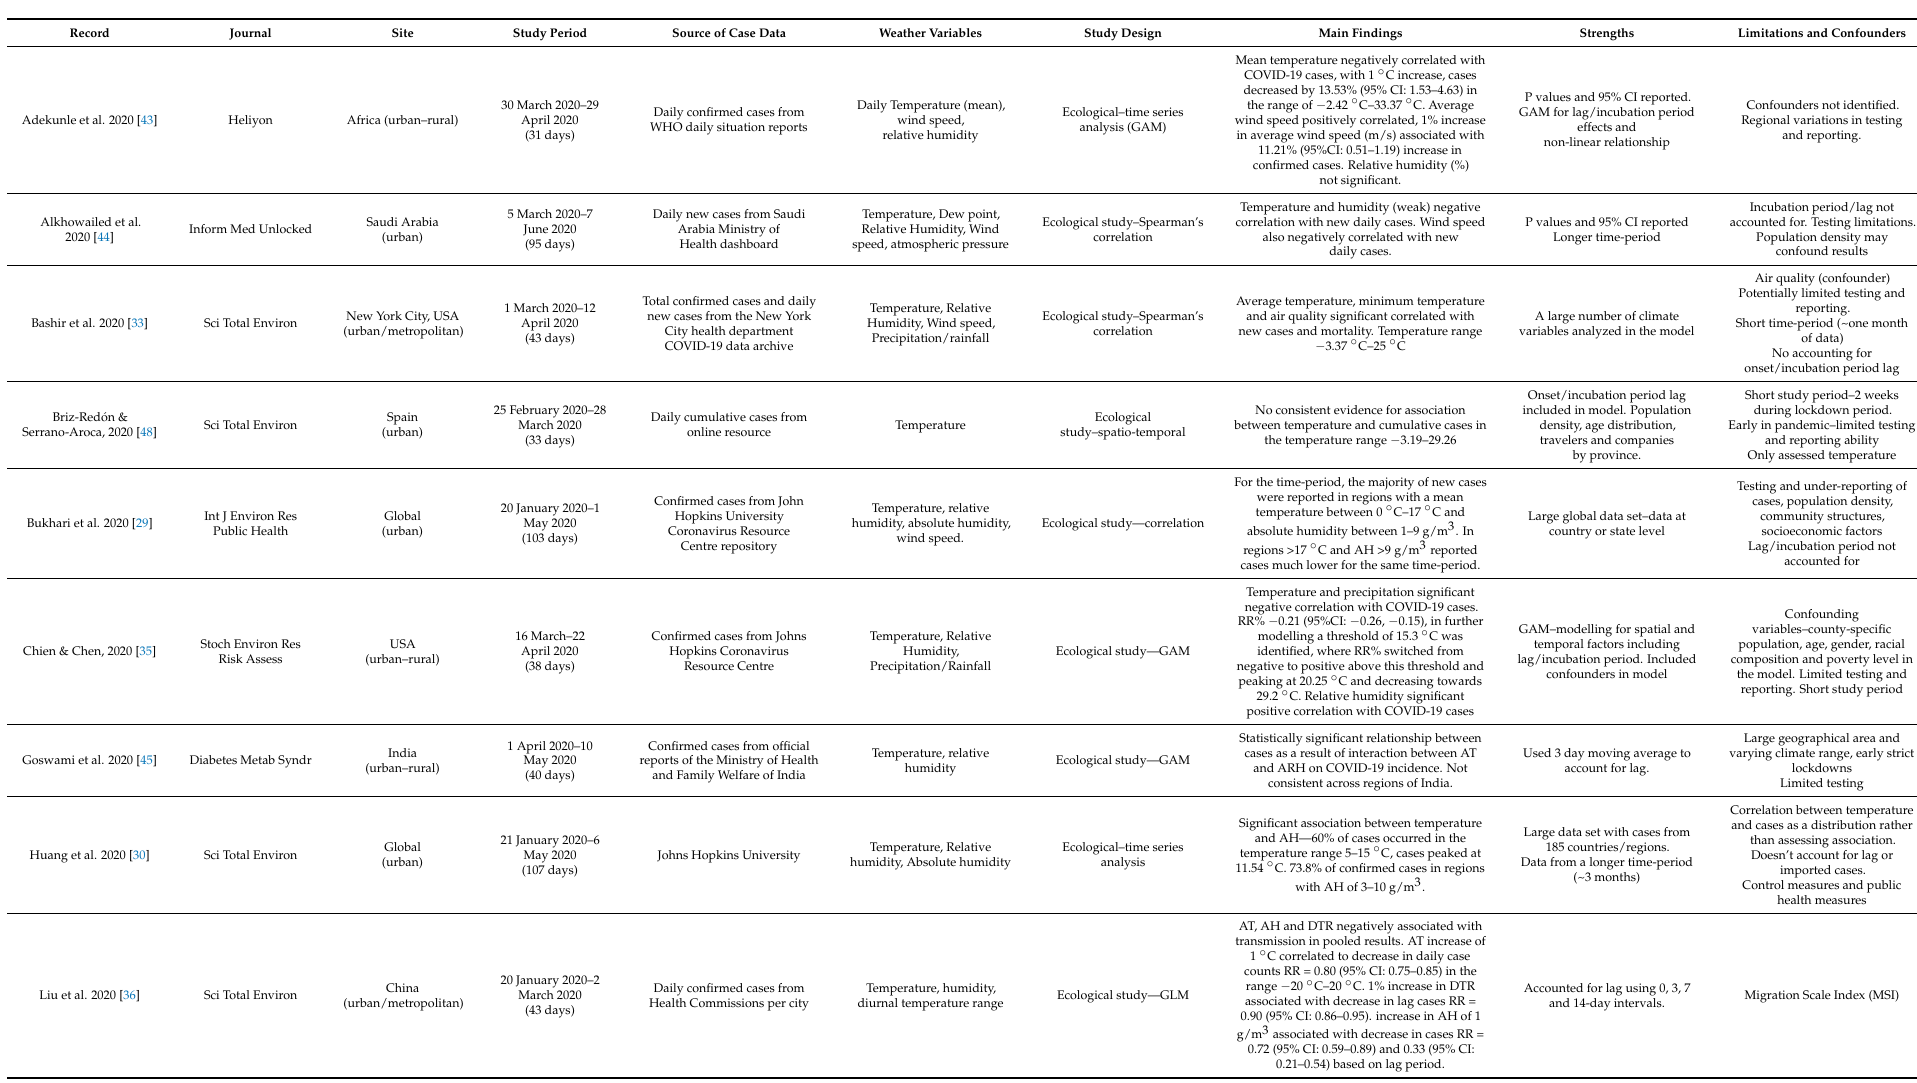
Table 1. Characteristics of epidemiological studies on weather variables and COVID-19